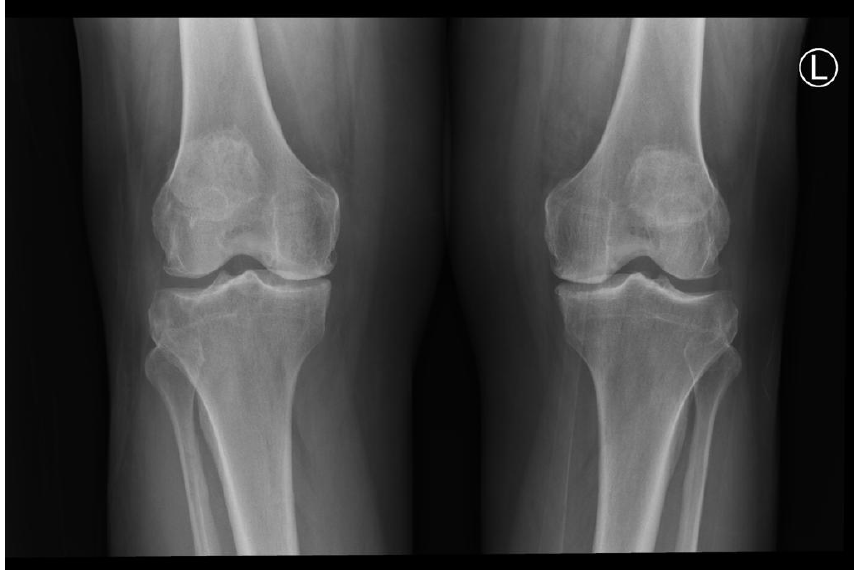
Figure 1. Patient’s X-rays showing osteoarthritic knee changes . Subsequently, the patient underwent total bilateral knee arthroplasty by the standard midline approach on the para patellar region by Zimmer, USA, without lateral retinacular release. The patient's surgery was successful; his postoperative knee joint X-rays can be seen in Figure 2.